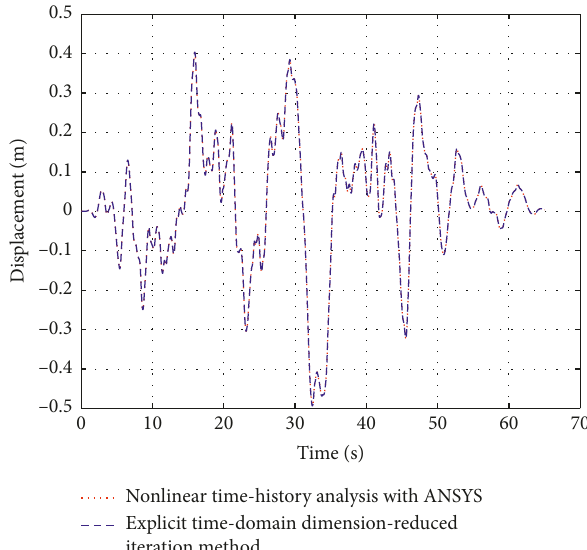
Figure 8: Longitudinal displacement at midspan of the main girder.